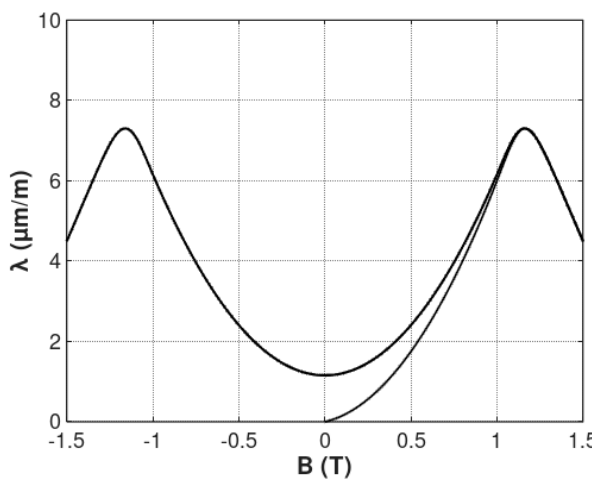
Figure 3. The flux density B dependence of anhysteretic magnetostriction λ anhyst considering the “lift-off” phenomenon, calculated for the following parameters: a 1 = 5 µ m (cid:2869) 1 . k = 0.1, a lift-off = 1 µ m . m T (cid:2923) (cid:2904)